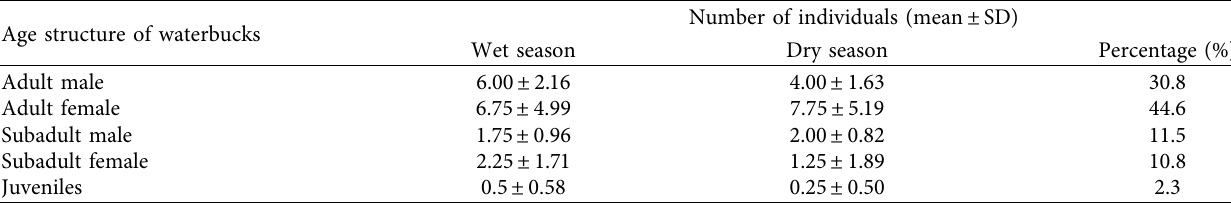
Table 3: The proportion of age and sex categories of waterbucks observed in both